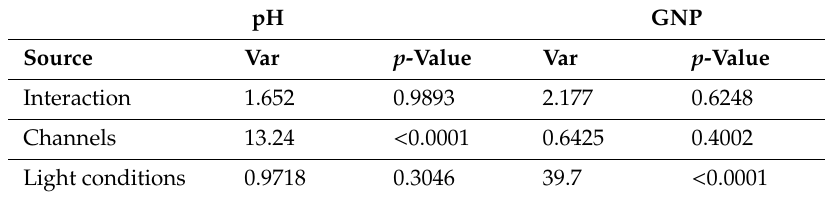
Table 5. Two-way ANOVA on background illumination and channel for GNP, and pH